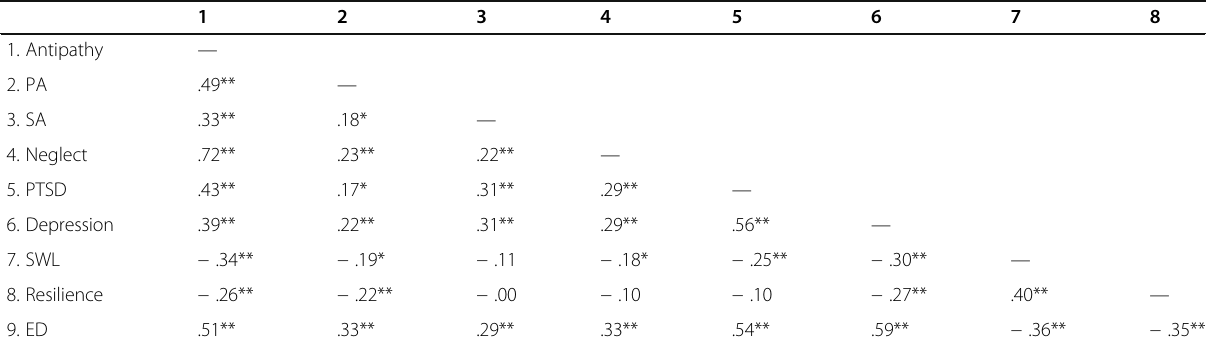
Table 2 Correlations for study